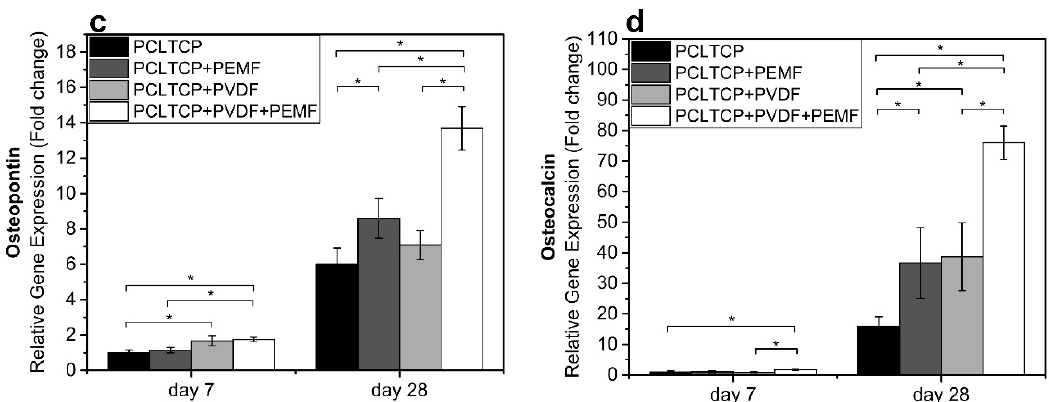
Figure 5. Osteogenic gene expression of early differentiation markers ( a ) RUNX2 and ( b ) bone sialoprotein ( BSP ) and late bone differentiation markers ( c ) osteocalcin ( OC ) and ( d ) osteopontin ( OP ). Sample groups: PCL-TCP without (PCL-TCP) and with PEMF (PCL-TCP+PEMF), PVDF-coated PCL-TCP without (PCL-TCP+PVDF) and with PEMF (PCL-TCP+PVDF+PEMF) (* p < 0.05, n = 3). Table 1. Summary of the effect of PEMF and PVDF coating on osteogenesis of MC3T3-E1 cells as compared with the control group of PCL-TCP scaffolds.